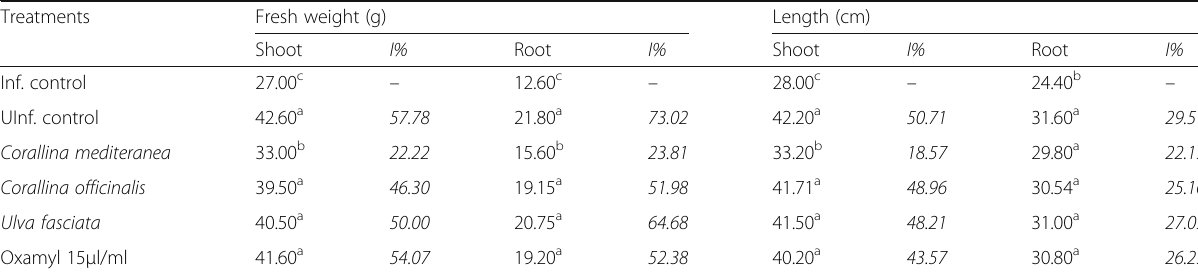
Table 4 Effect of three marine algal extracts against the root-knot nematode, Meloidogyne incognita on vegetative growth parameters of tomato plants grown in the greenhouse Treatments Fresh weight (g) Length (cm) Shoot I% Root I% Shoot I% Root I% Inf. control UInf.